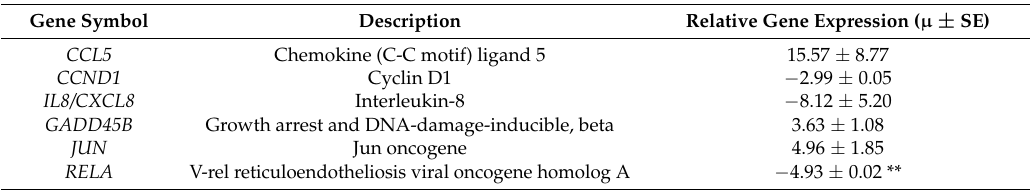
Table 1. Basal gene expression in HEK shRNA RelA cells compared to the original cell